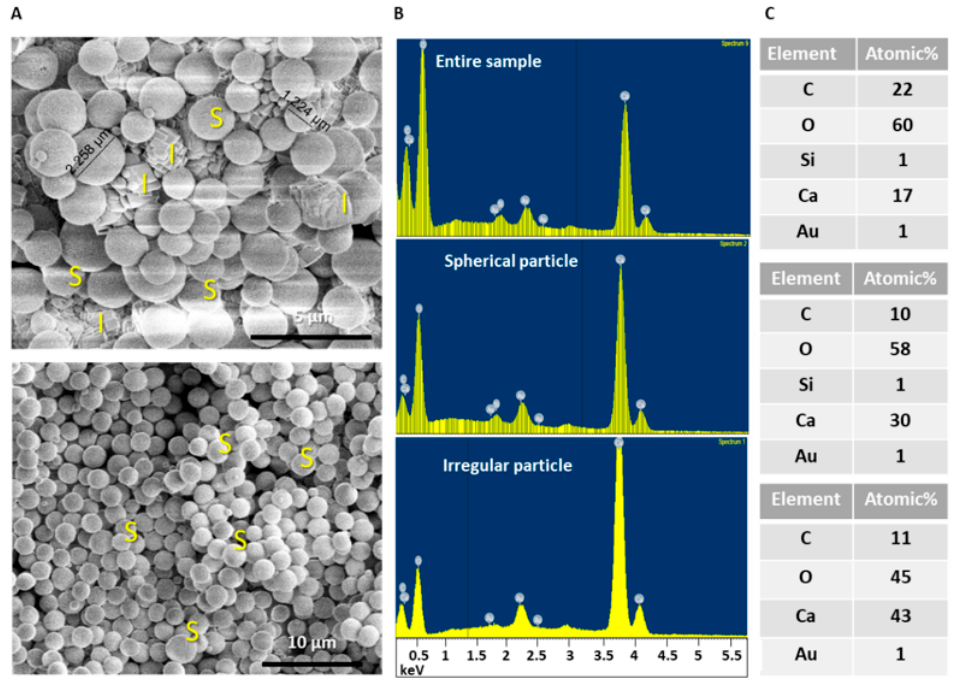
Figure 2. Silicon element found in sphere particles after EDS elemental analysis of CaCO3 with CMC (sample 1A). The analysis includes the overall sample, single spheres, and single irregular shaped particles. ( A ) SEM images of the particles which were targeted by EDS. ( B , C ) Elemental analysis of the overall sample and targeted particles. Silicon was found in the entire sample and in spherical particles.